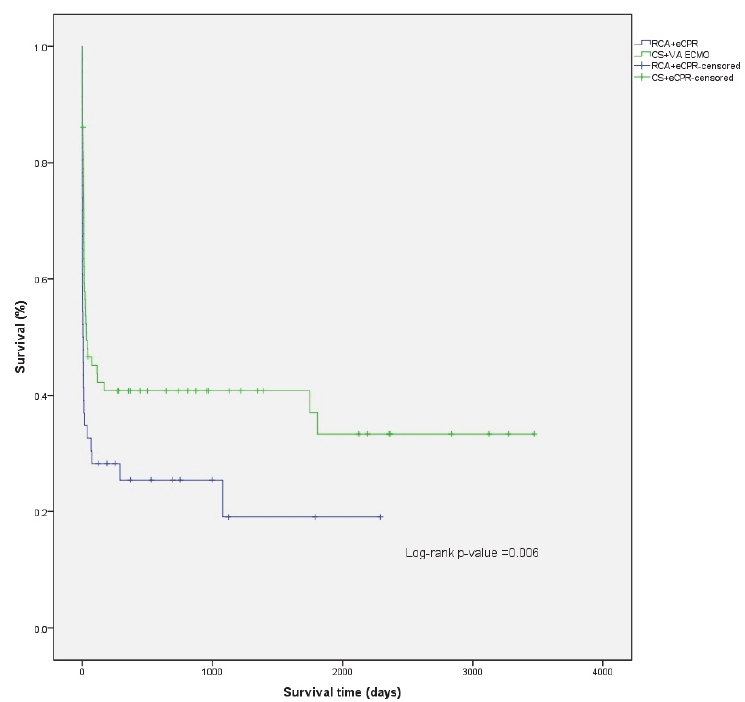
Figure 1. Comparison of Kaplan–Meier overall survival curves for CS and RCA patients.